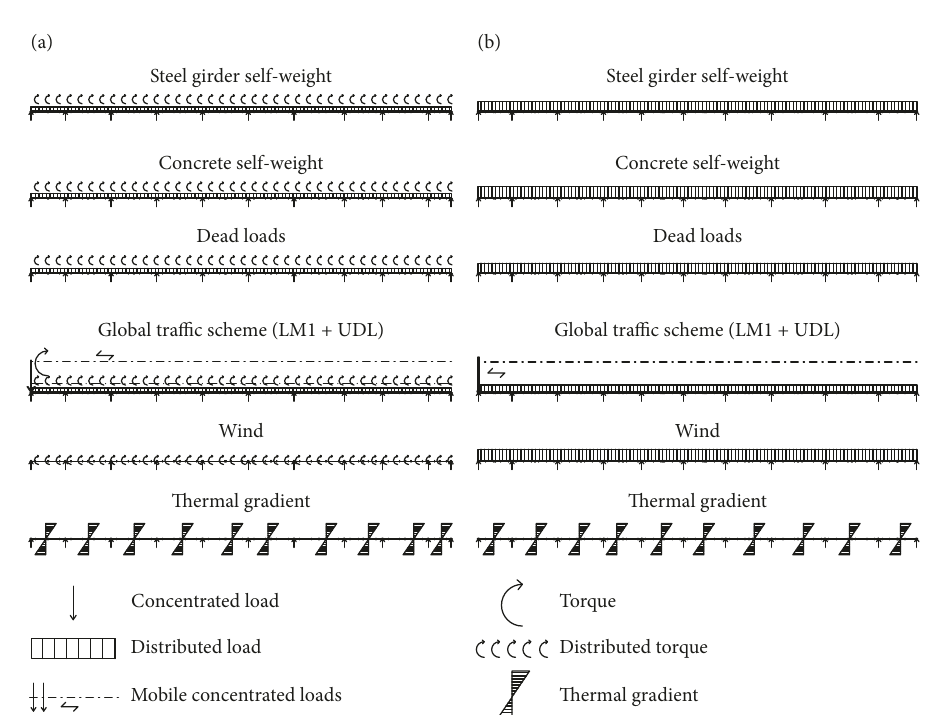
Figure 7: Schematic representation of the applied loads for the girder analysis. (a) Alternative 1: G1. (b) Alternative 2: